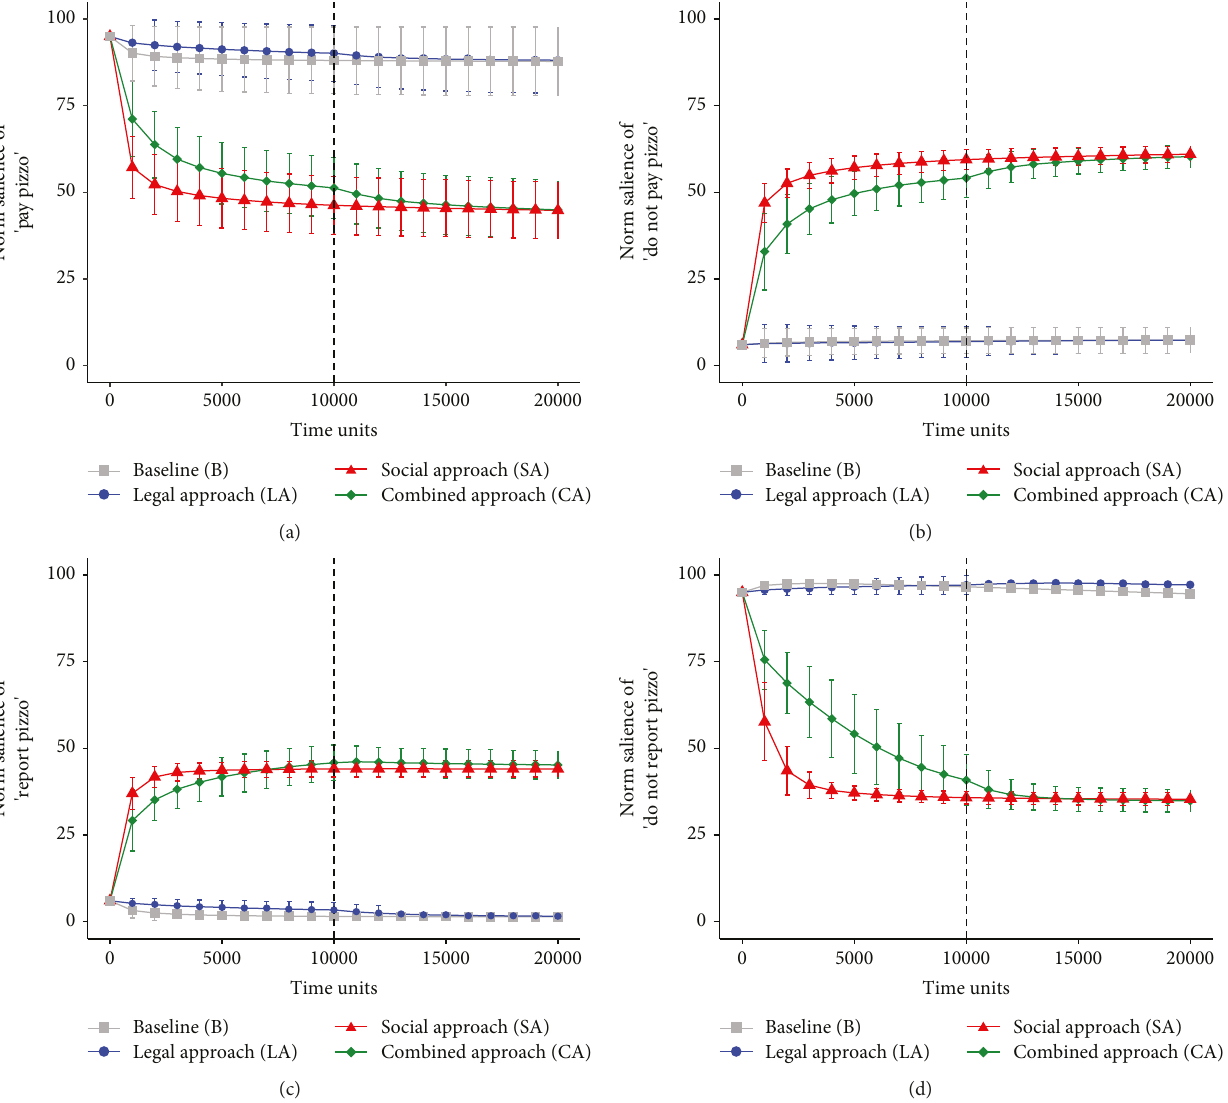
Figure 6: Social norm importance in the population. Means plotted and error bars indicate ± 1 standard deviation. Saliences of the social norm (a) pay pizzo, (b) do not pay pizzo, (c) report pizzo, and (d) do not report pizzo. The dashed line indicates the change to baseline